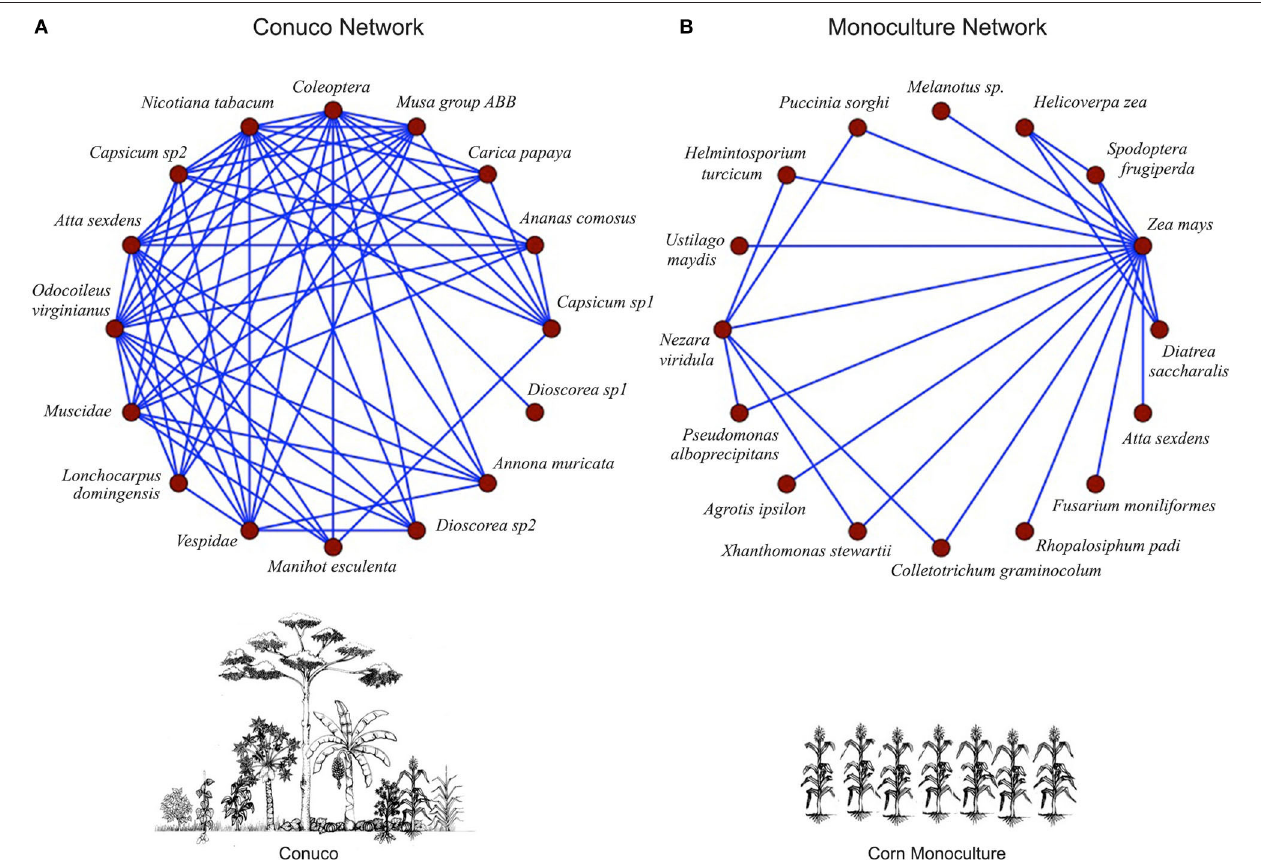
FIGURE 2 | Ecological networks associated with a Hiwi conuco (A) and a corn monoculture (B) . Nodes represent population species, links represent ecological interactions (modified from Griffon and Hernandez, 2014; Griffon and Rodríguez,